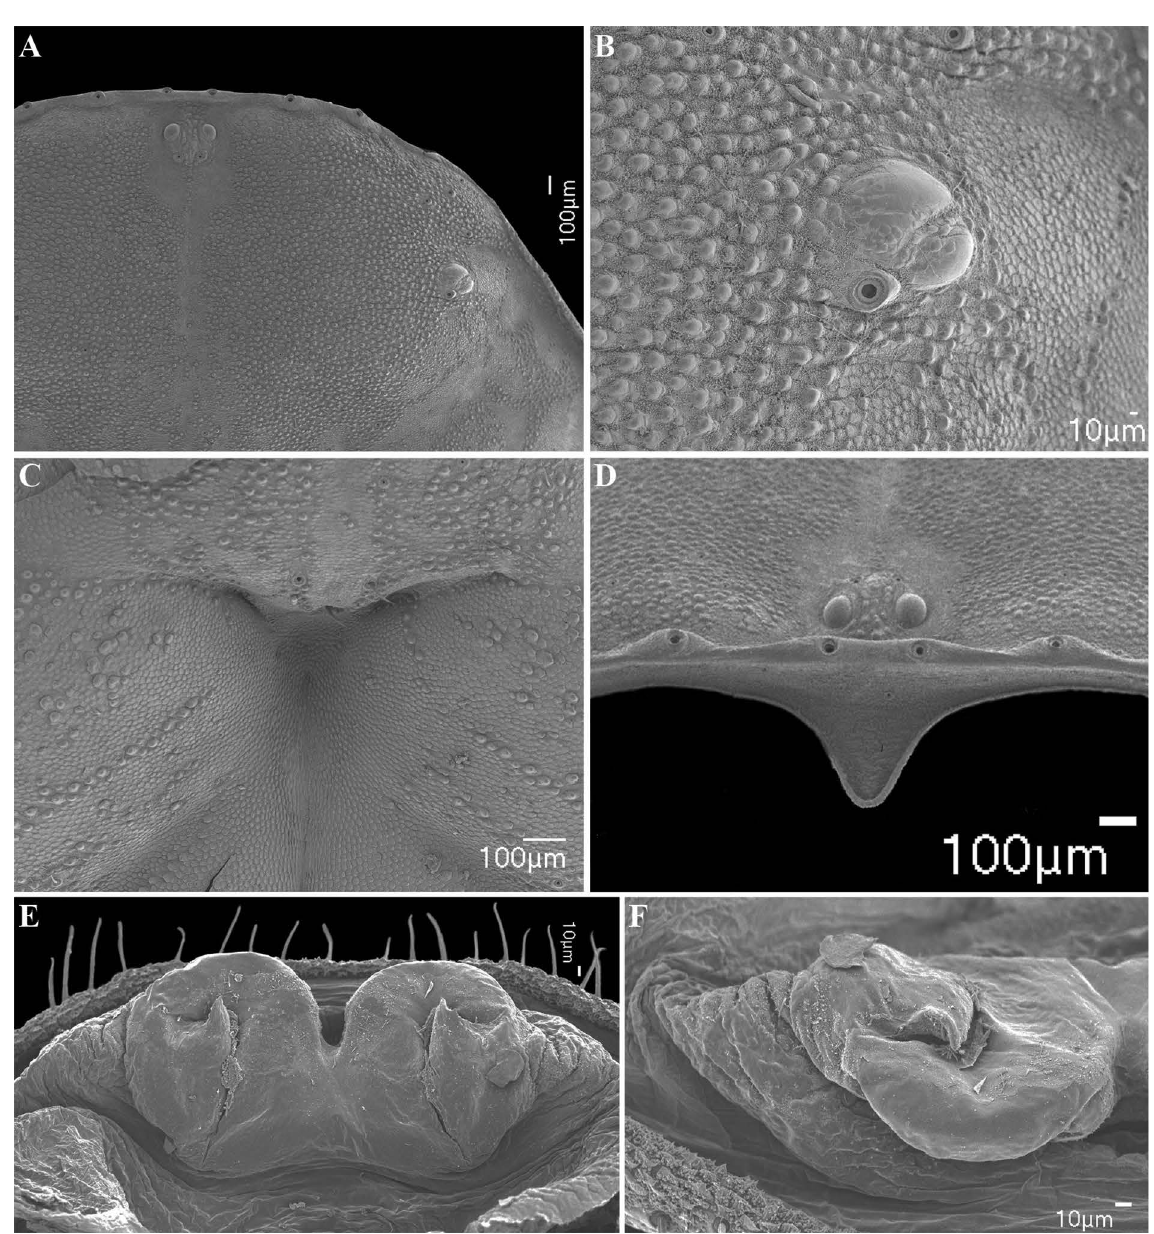
Fig. 37. Charinus insularis Banks 1902 (RBINS), carapace and female gonopod. A . Carapace, anterior part illustrating granular macrosculpture. B . Lateral ocular triad, setal socket and carapace macrosculpture. C . Fovea and granules. D . Frontal process. E . Female gonopod, dorsal view. F . Female gonopod, sinistral